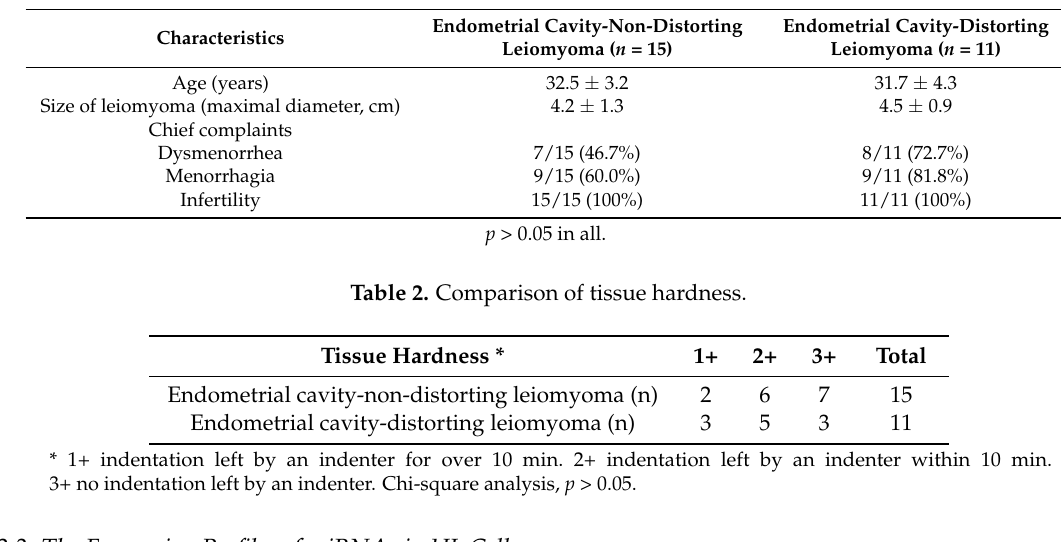
Table 1. Comparison of clinical characteristics.